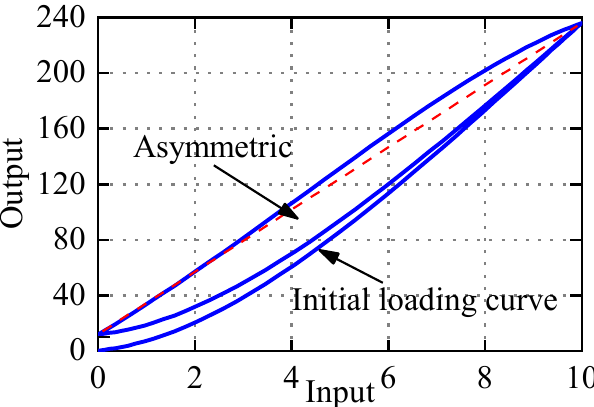
Figure 5. Hysteresis loops generated by polynomial-modified PI (PMPI) model.